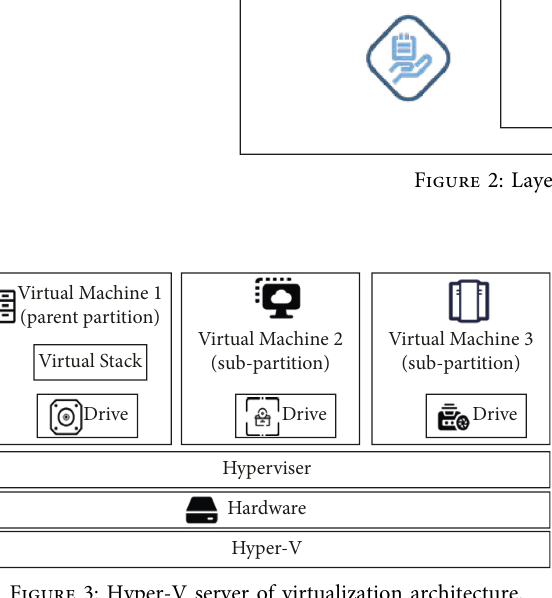
Figure 3: Hyper-V server of virtualization